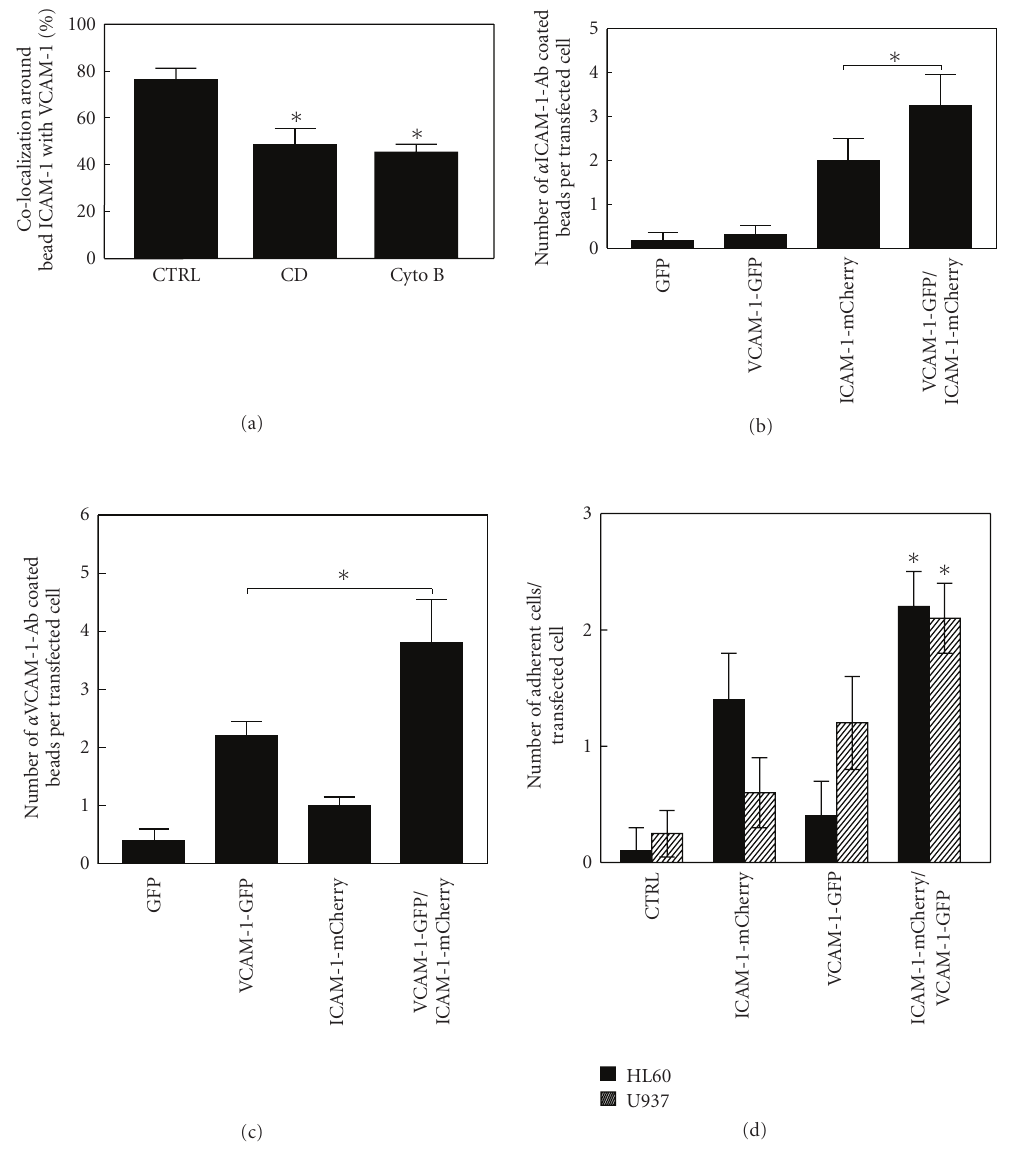
Figure 4: ICAM-1-induced VCAM-1 recruitment depends on lipid-rafts and actin polymerization and promotes ICAM-1-induced adhesion. (a) Anti-ICAM-1-antibody coated beads were allowed to adhere for 60 minutes to TNF α -stimulated HUVECs that were left untreated (CTRL) or were pretreated for 30 minutes with either cyclodextrin (CD; 3.8 μ M) or cytochalasin B (CytoB; 1 μ g/mL). Subsequently, cells were fixed and immunostained with ICAM-1-FITC and VCAM-1 Abs. VCAM-1 recruitment to ICAM-1 beads was quantified which showed that